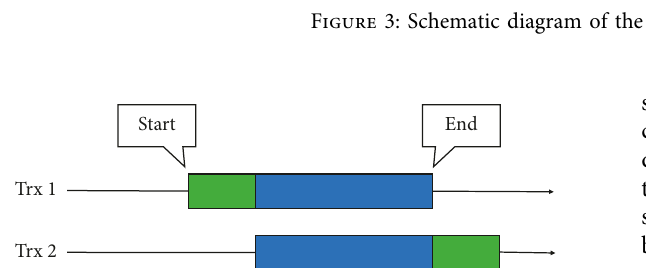
Figure 3: Schematic diagram of the data processing thread model.